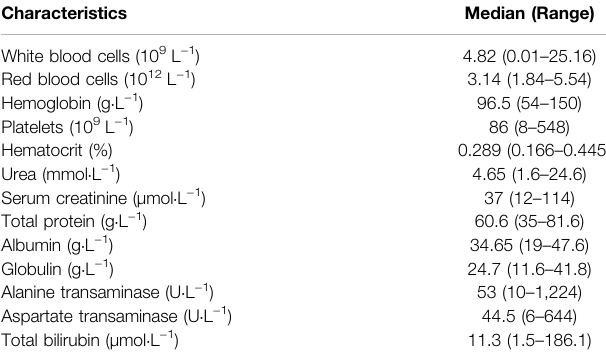
TABLE 2 | Clinical characteristics of patients.